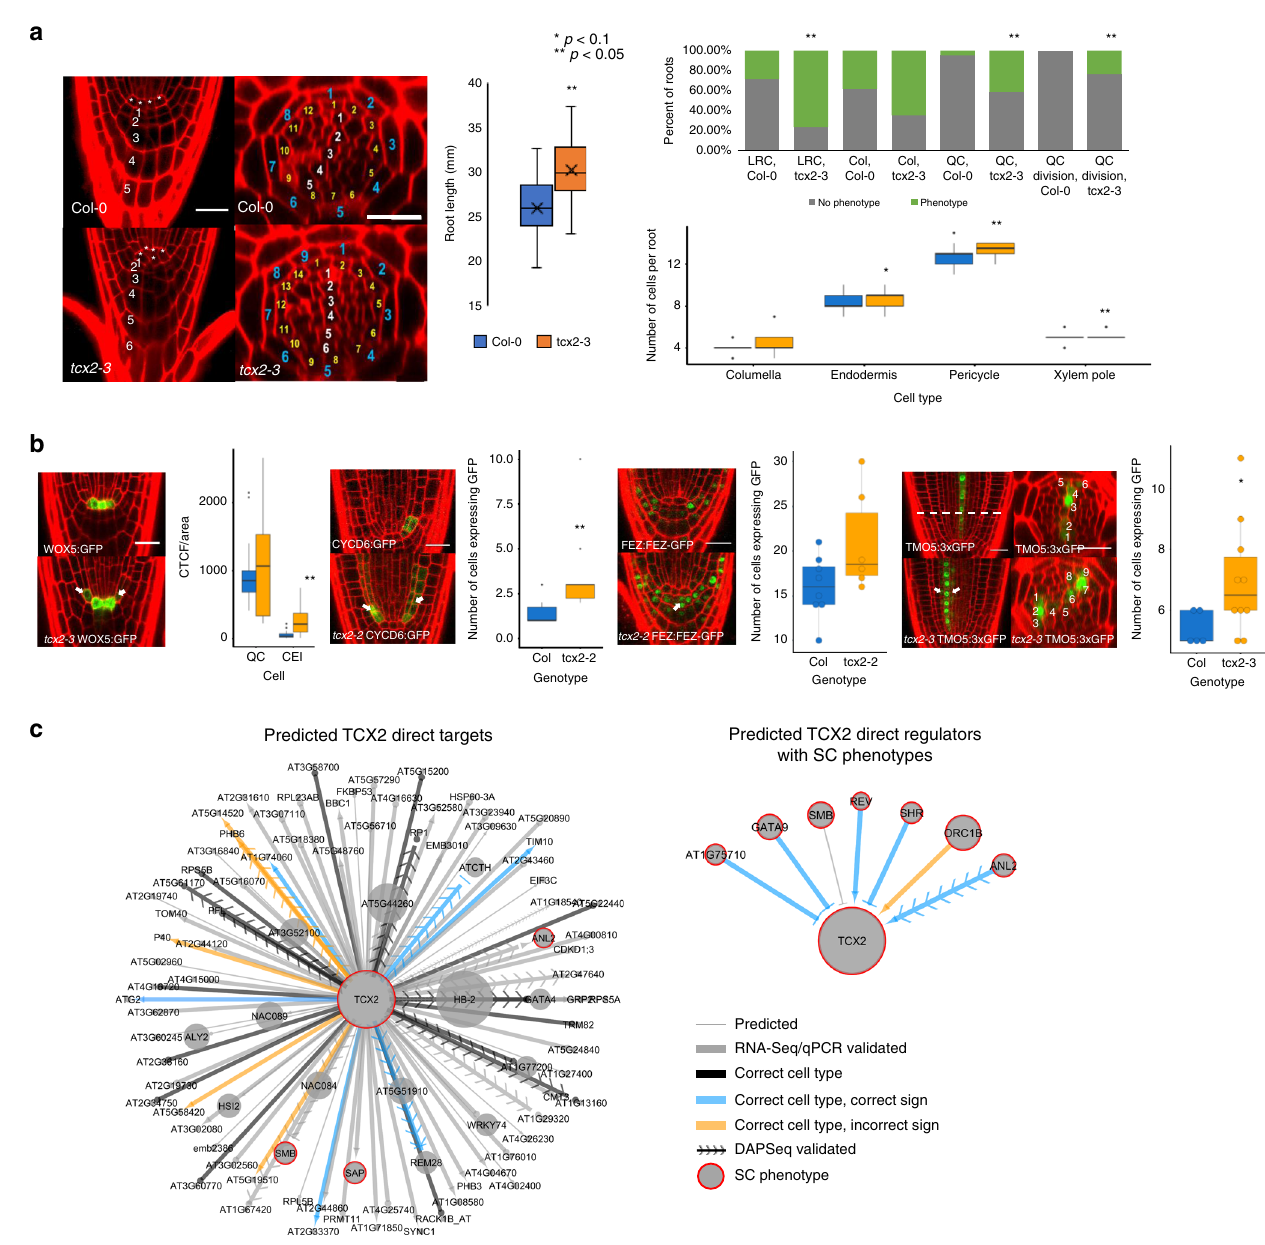
Fig. 3 TCX2 controls stem cell division through cell-speci fi c regulators and targets. a (Left) Medial longitudinal (left) and radial (right) sections of 5-day-old WT (top) and tcx2 -mutant (bottom) plants. In medial longitudinal sections, asterisk labels QC cells and numbers denote columella cell fi les. In radial sections, white numbers denote xylem cells, yellow pericycle, and blue endodermis. Scale bar = 20 µ m. (Middle) Length of 7-day-old WT (blue, n = 18) and tcx2 mutant (orange, n = 18) roots. Center line represents median; box bounds represent 25th and 75th percentiles; whiskers represent minimum and maximum values. Black X represents the mean. (Right) Quanti fi cation of stem cell phenotypes (top plot) and number of cell fi les (bottom plot) in 5-day old WT ( n = 21) and tcx2 mutant ( n = 17) roots. In top plot, green denotes the percent of roots that showed a phenotype, while gray denotes the percent of roots that did not show a phenotype. LRC, Col (Columella), QC refers to a cell disorganization phenotype in those cells. Asterisk denotes p < 0.1, Double asterisks denote p < 0.05, Wilcoxon test. b (Left) Medial longitudinal sections of 5-day-old WOX5:GFP (left), CYCD6:GFP (second from left), FEZ:FEZ-GFP (third from left), and TMO5:3xGFP (right) in WT (top) and tcx2 -mutant (bottom) plants. For TMO5:3xGFP, a radial section (middle) was taken at the location of the white, dashed line. (Right) Quanti fi cation of GFP in WT (blue, n = 35, n = 8, n = 5 for CYCD6, FEZ, TMO5) and tcx2 -mutant (orange, n = 25, n = 6, n = 10 for CYCD6, FEZ, TMO5) plants. Center line represents median; box bounds represent 25th and 75th percentiles; whiskers represent minimum and maximum excluding outliers. Black dots represent outliers. Colored dots represent individual data points. Asterisk denotes p < 0.1, double asterisks denote p < 0.05, Wilcoxon test. c (Left) Predicted direct targets of TCX2 and (right) predicted upstream regulators of TCX2 with stem cell (SC) phenotypes. Gene size represents the NMS score. Red borders represent the genes that have a known SC phenotype. Arrows represent predicted activation, bars repression, and circles no predicted sign. Thick edges were validated using qPCR/RNA-Seq. Black edges were predicted in the correct cell type but did not have a predicted sign. Blue edges have the correct cell type and correct sign, while orange edges have the correct cell type but the incorrect sign. Arrows with chevrons are DAPSeq validated. Source data are provided as a Source Data fi